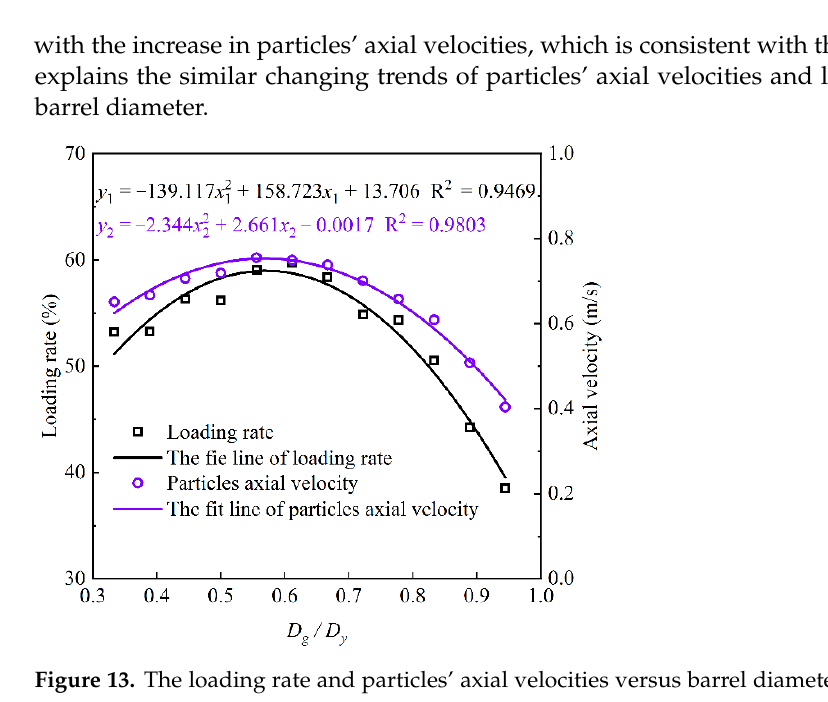
Figure 13. The loading rate and particles’ axial velocities versus barrel diameter in ejection mode ( D y = 900 mm).